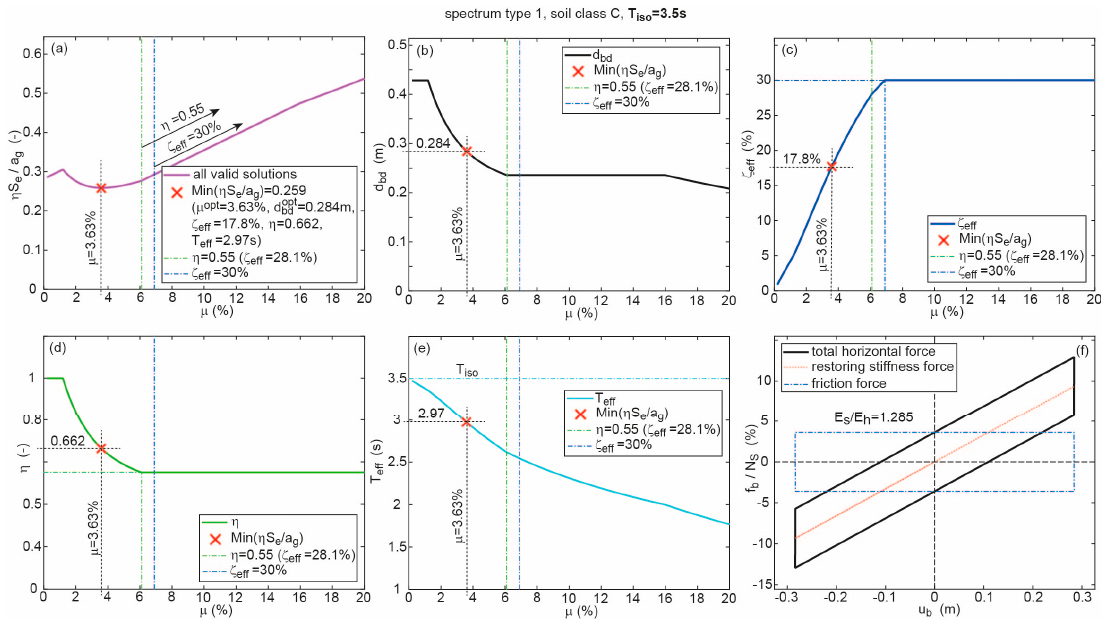
Figure 5. ( a – e ) Optimization results for T iso = 3.5 s as function of friction coefficient and ( f ) force displacement curve of optimum CSS design for spectrum type 1 with soil class C.